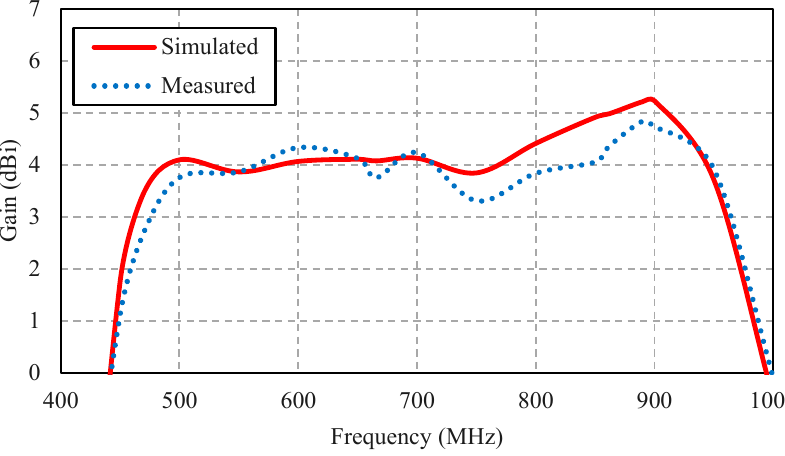
Figure 18. Simulated and measured gains of the portable wideband directional antenna scheme. As shown in Figure 19, the radiation pattern of the proposed portable wideband horizontally polarized directional antenna scheme was of unidirectionality. The measured xz- and yz-plane cross-polarizations were below − 20 dB and − 40 dB, respectively, with the corresponding HPBW of 150 ◦ , 159 ◦ , and 160 ◦ and 102 ◦ , 78 ◦ , and 102 ◦ at 470 MHz, 680 MHz, and 890 MHz, respectively. The discrepancy between the simulated and measured cross- polarization could be attributed to the use of self-trapping screws in the antenna prototype fabrication, as shown in Figure 16a. The measured xz- and yz-plane back lobe levels were below − 9 dB. The experiments also revealed that the ABS radome had negligible impacts on the impedance bandwidth and the antenna gain, vis- à -vis the antenna scheme without the ABS radome. Table 2 tabulates the simulated and measured performance of the proposed portable wideband directional antenna scheme. Table 3 shows a comparison between previous works and the proposed portable wideband directional antenna